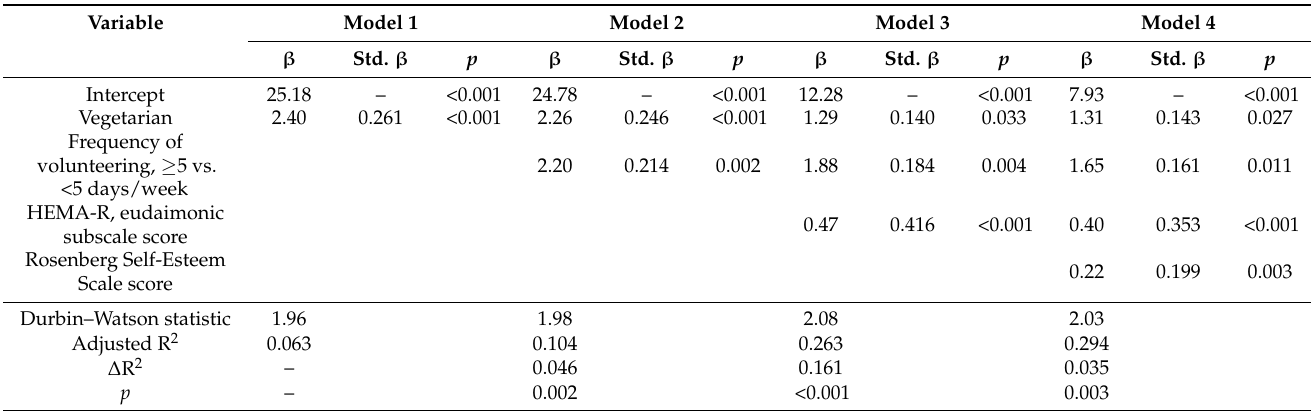
Table 3. Hierarchical linear stepwise regression analysis of the Satisfaction with Life Scale score (N =